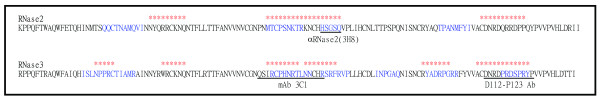
Analyses of RNase2 and RNase3 by RMA and PROTEAN. The RNase2 and RNase3 analyzed by RMA are extracted and modified from Figure 1A, and the UPMs are labeled in blue. The potential antigenic regions in RNase2 and RNase3 predicted by PROTEAN are labeled in red stars on top of each sequence. The epitopes of αRNase2, mAb 3C1 and D112-P123 Ab are underlined.